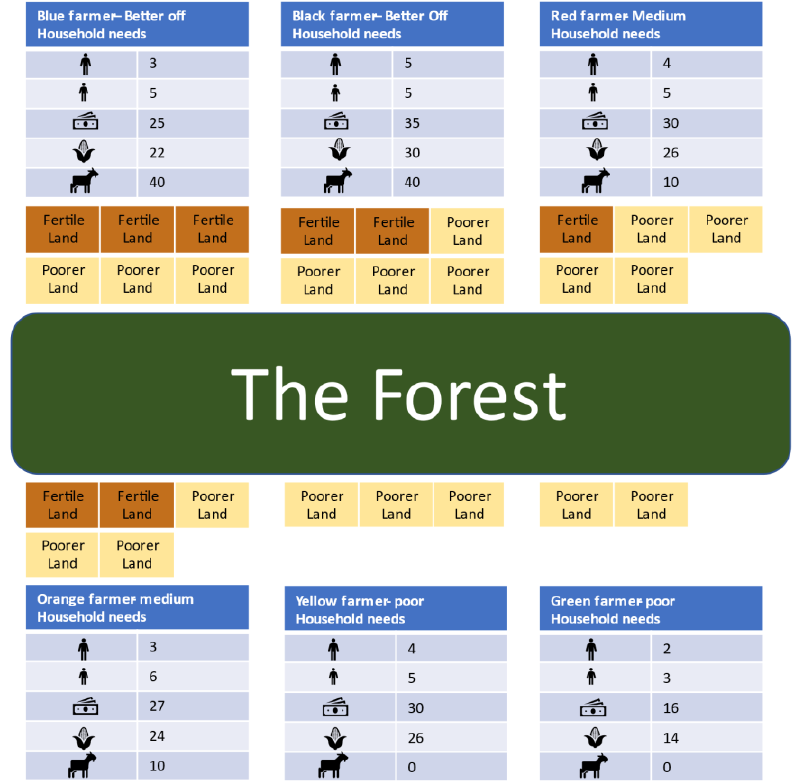
Figure 2. The game board layout. Source: the authors. The forest (centre) is surrounded by six farming households. Each household has a certain set of farmland conditions (fertile and less fertile patches of land). Household represents three levels of “wealth”, with different amounts of physical, social, and natural assets [72] detailed on their “game cards”.